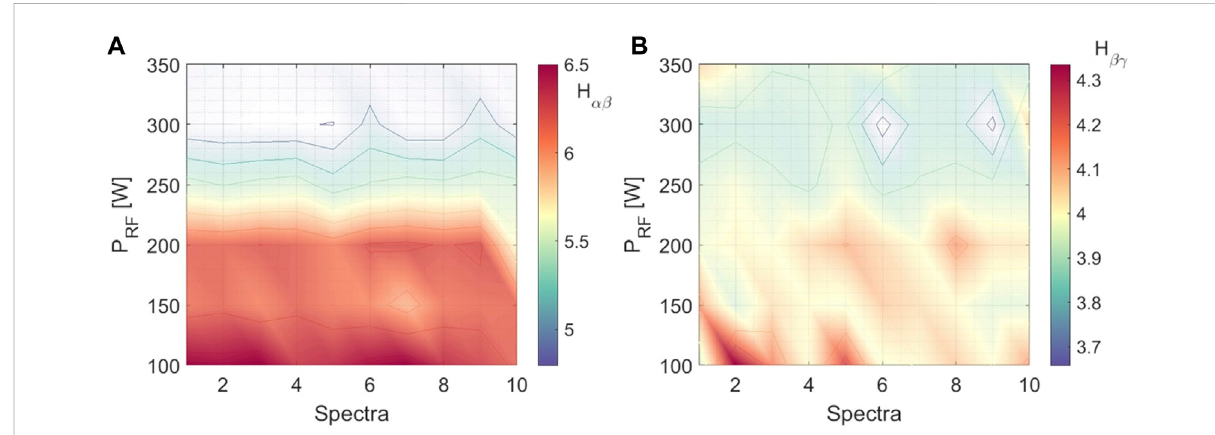
FIGURE 4 Monitoring of H αβ (A) and of H βγ (B) in the RF power (P RF [W]) - spectra plane. Both refer to the experimental run 3, at f RF = 3.76 GHz, p 0 = 1 E − 03